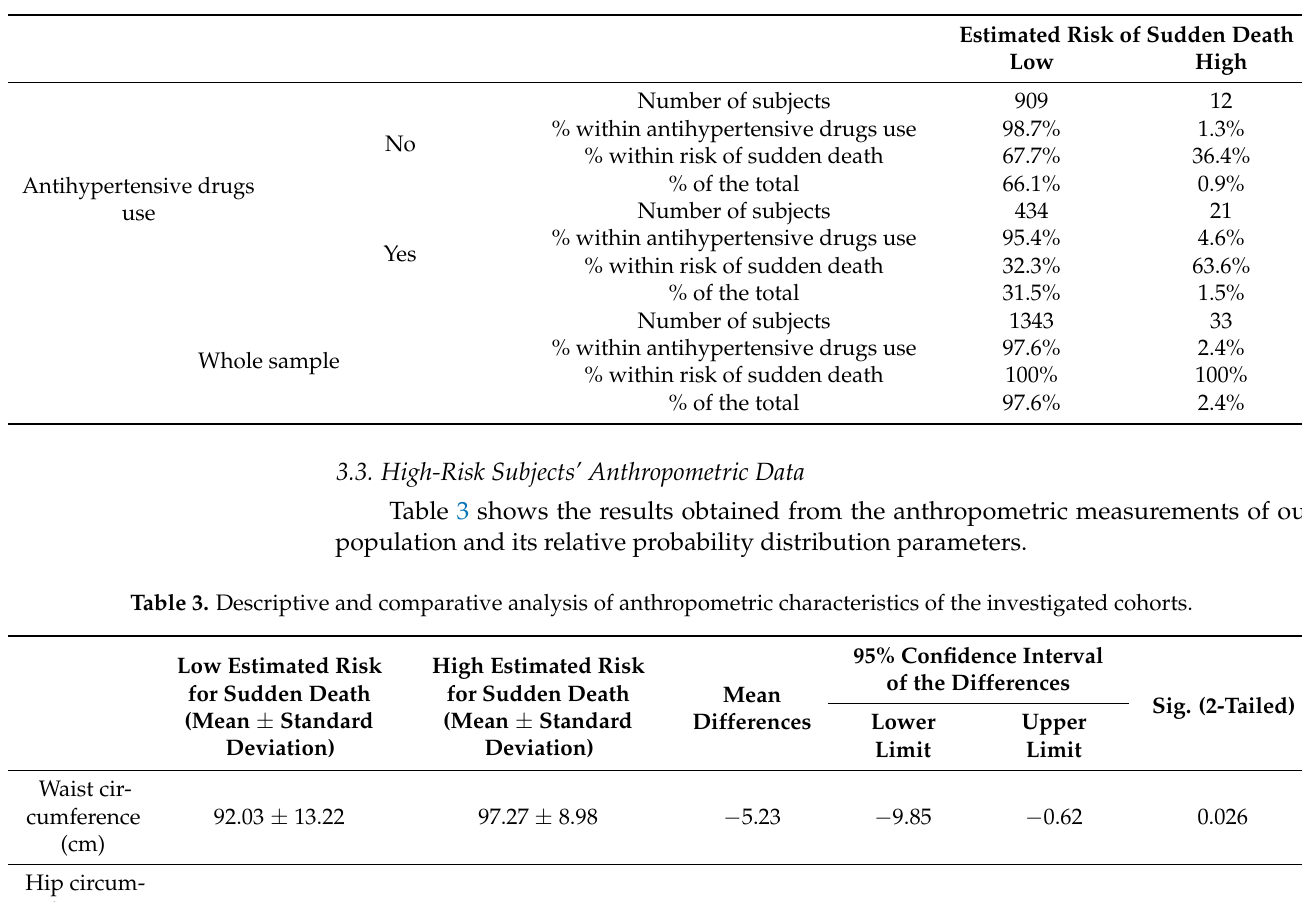
Table 2. Contingency table about antihypertensive drugs use in the 2016 BHS Survey subpopulations, according to the ECG risk score.